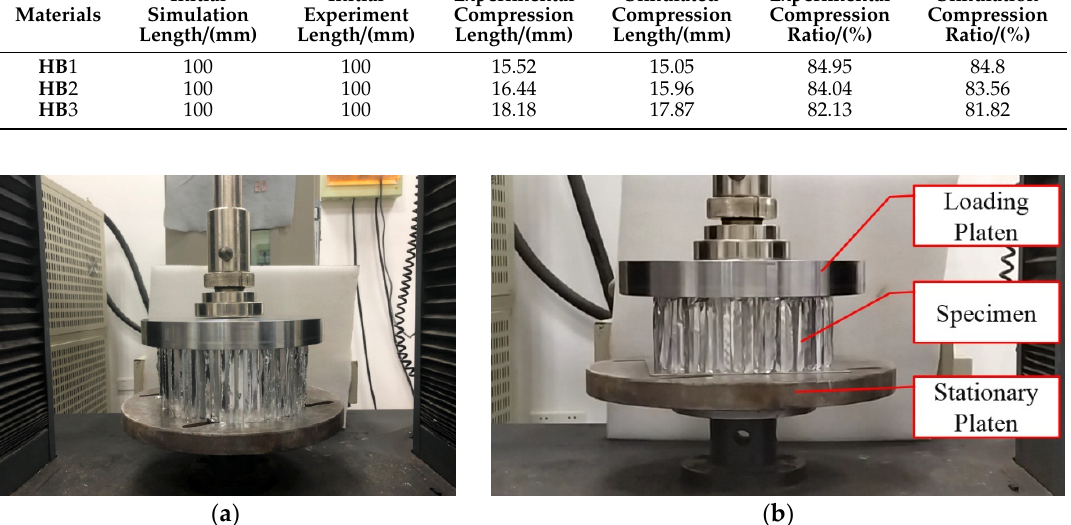
Figure 5. Static pressure experiment of material. ( a ) Placement of experimental material, ( b )The process of static pressure experiment .